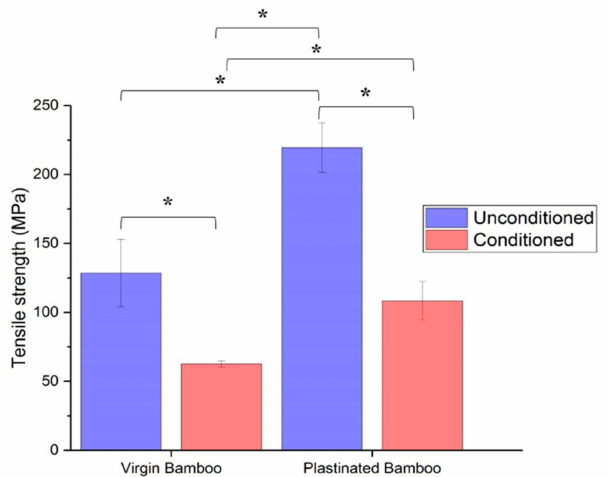
Figure 7. Tensile strength of virgin and plastinated bamboo, before and after moisture conditioning. * indicates a significance level with p -value <